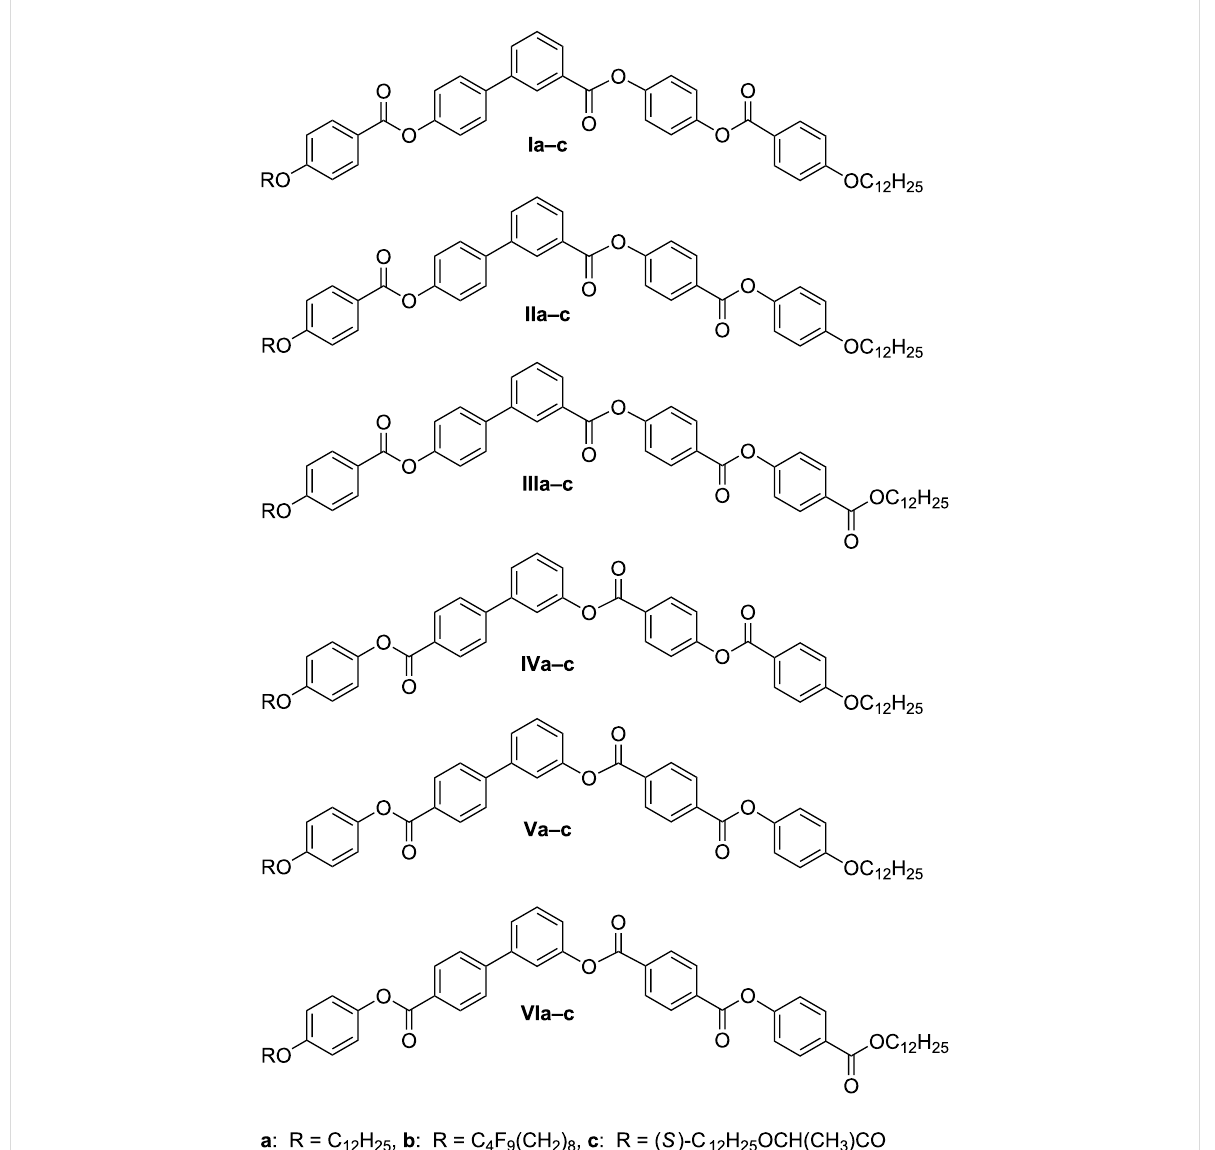
Figure 2: Chemical formulae of studied compounds I – VI .